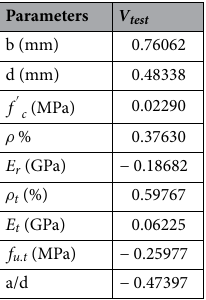
Table 2. correlation values between predictors and FRP reinforced concrete V s .